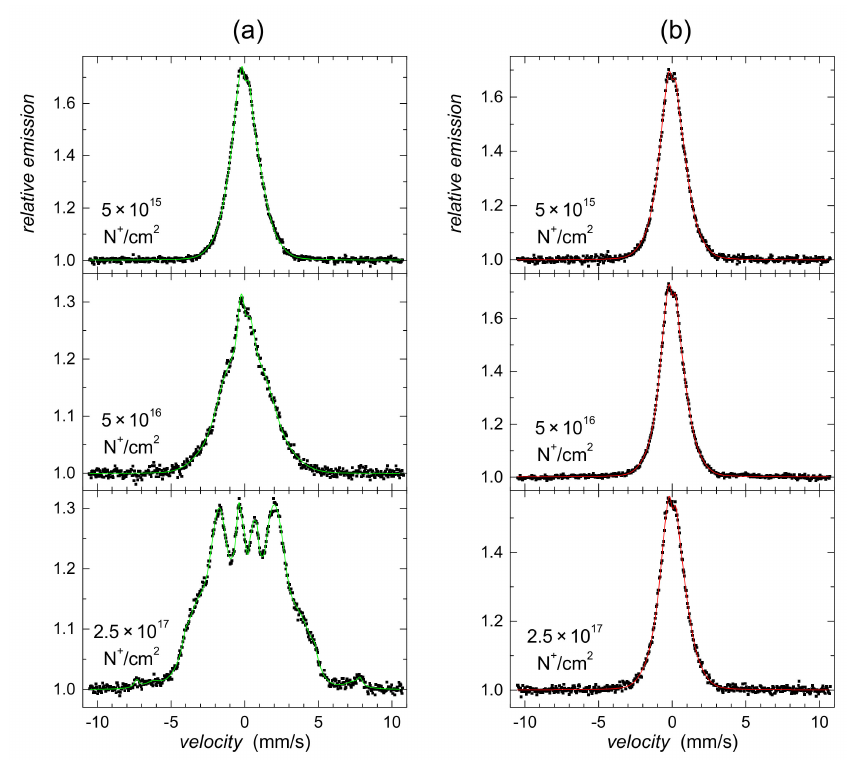
Figure 15. CEMS spectra of 57 Fe 75 Mo 8 Cu 1 B 16 amorphous metallic ribbons recorded from its: ( a ) air side (green); ( b ) wheel side (red) of the ribbons after irradiation by 130 keV N + ions with the indicated fluences.